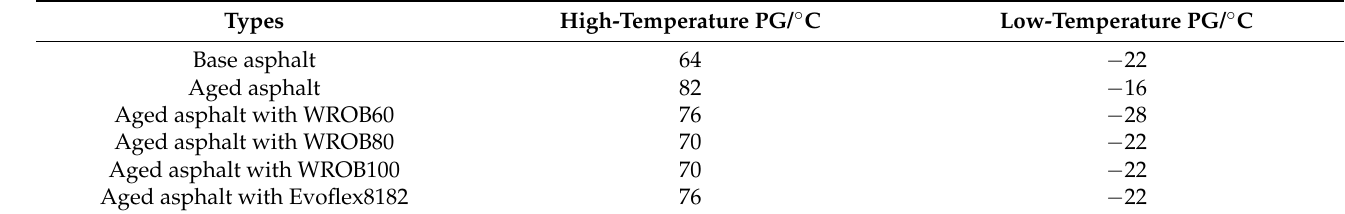
Table 10. High and low-temperature performance grade of different asphalt binder [39].